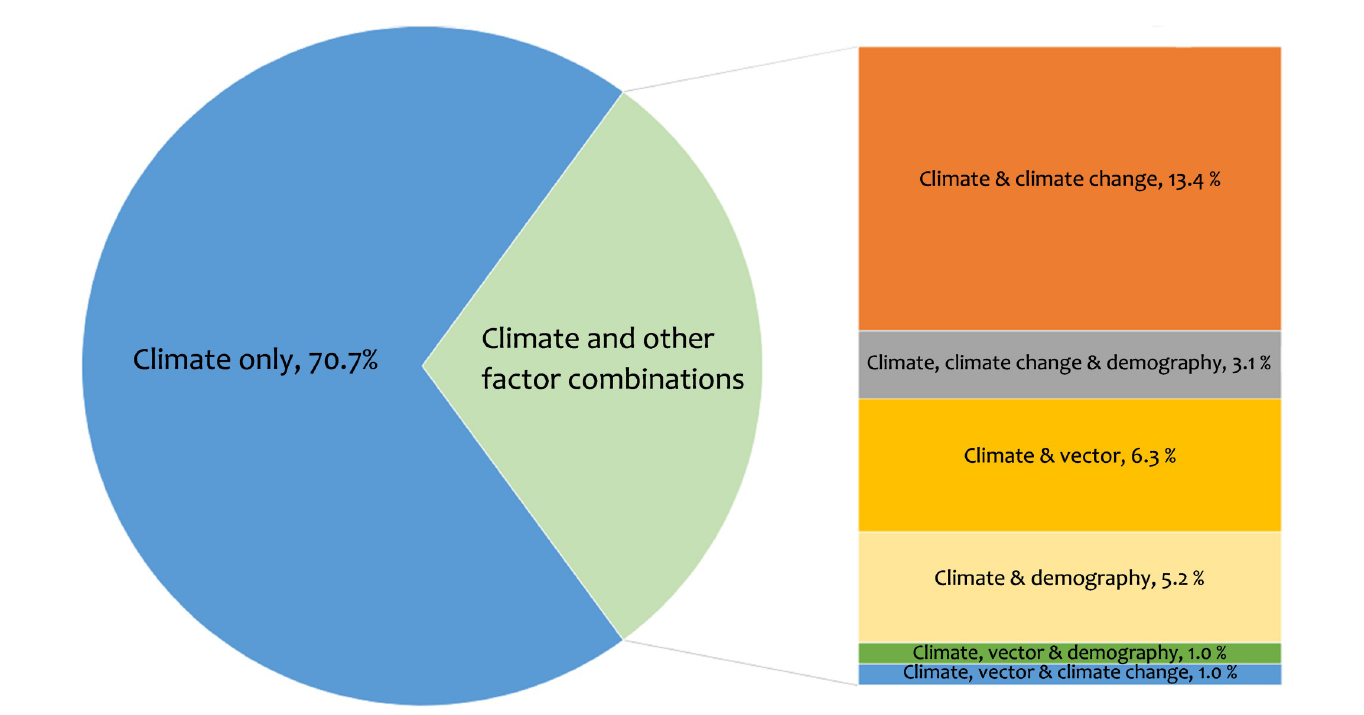
Fig 2. Combinations of predictors used in the prediction